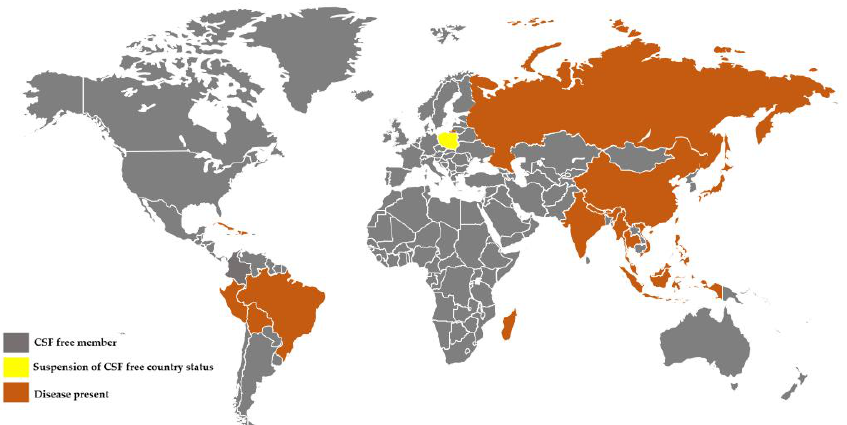
Figure 1. Global distribution of CSF epidemics in 2021. Romania was delisted from its CSFV-free country status in 2020. Map based on data from the CABI Invasive Species Compendium and official data from the OIE (accessed on 5 March 2022).